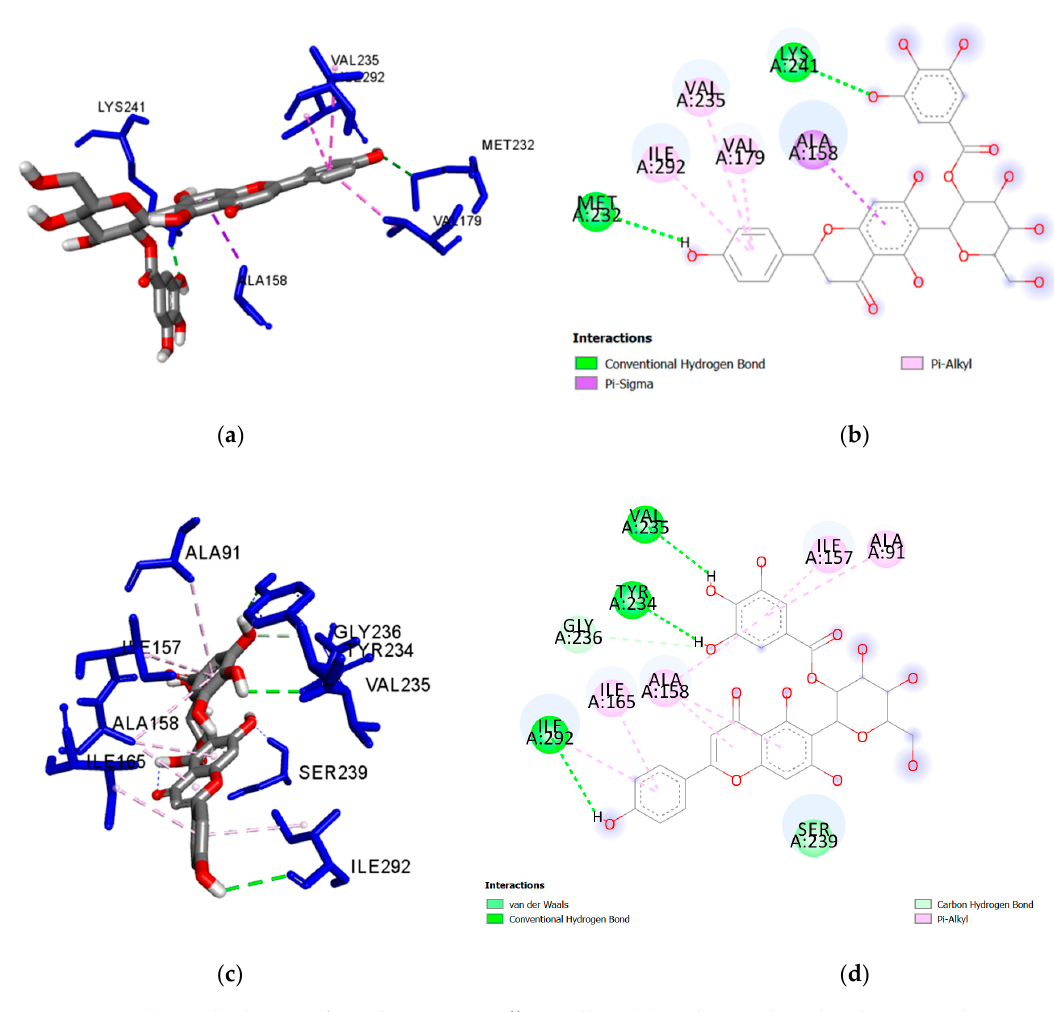
Figure 3. ( a ) Docked pose of rigid isovitexin 2”- O -gallate ( 2 ) in the Mt PknG binding site, showing molecular interactions—hydrogen and hydrophobic bonds as green and pink/purple dashed lines, respectively; ( b ) 2D plot of interactions between ( 2 ) and key residues of Mt PknG generated by BIOVIA Discovery Studio visualizer. The solvent accessible surface is depicted as a background grey circle with the radius proportional to the exposure. ( c ) Docked pose of flexible isovitexin 2”- O -gallate ( 2 ) in the Mt PknG binding site showing molecular interactions—hydrogen and hydrophobic bonds as green and pink/purple dashed lines, respectively; ( d ) 2D plot of interactions between ( 2 ) and key residues of Mt PknG generated by BIOVIA Discovery Studio visualizer. The solvent accessible surface is depicted as a background grey circle with the radius proportional to the exposure. Table 1. Identified binding sites for Mt PknG using SiteMap.